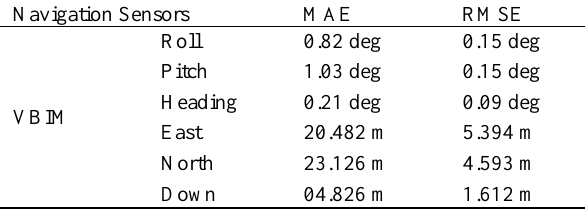
Table 5. The VBIM navigation system accuracy Navigation Sensors